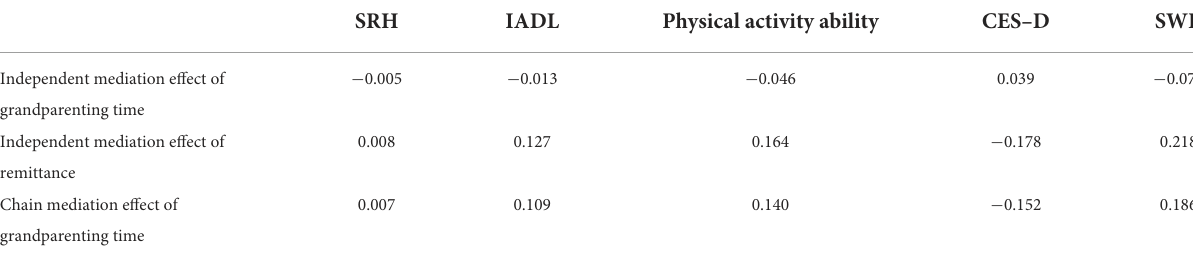
TABLE 6 Mediating effect of grandparenting time and children’s financial